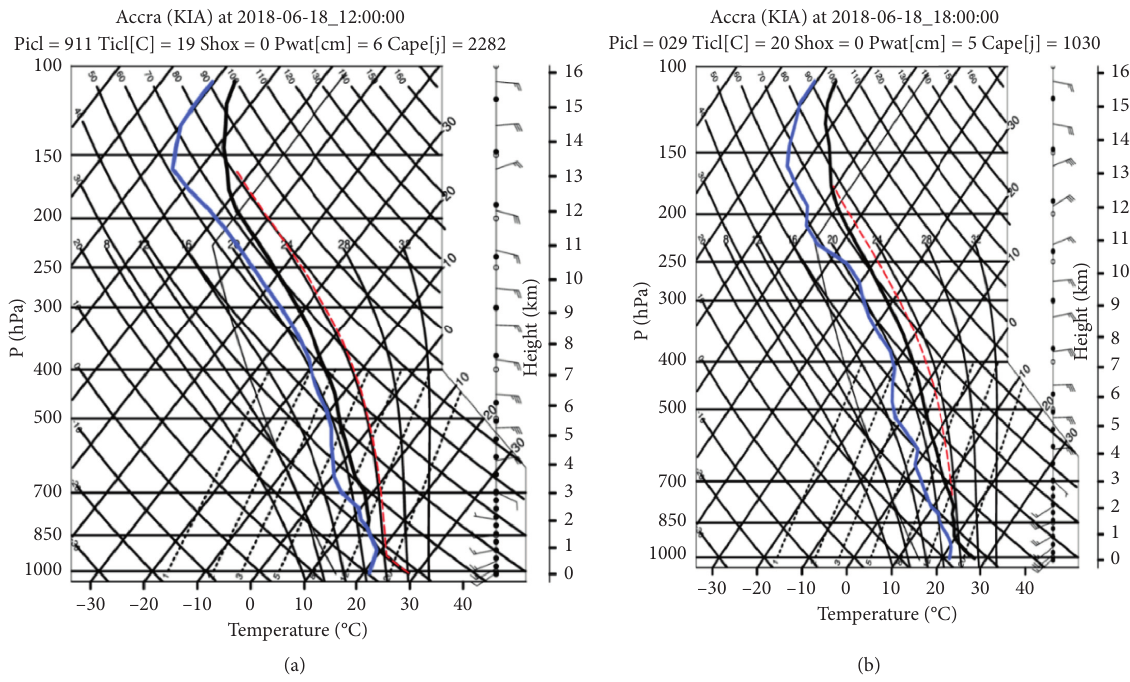
Figure 14: WRF skew-T diagram showing atmospheric dynamics for case A (a) at 12 UTC and (b) at 18